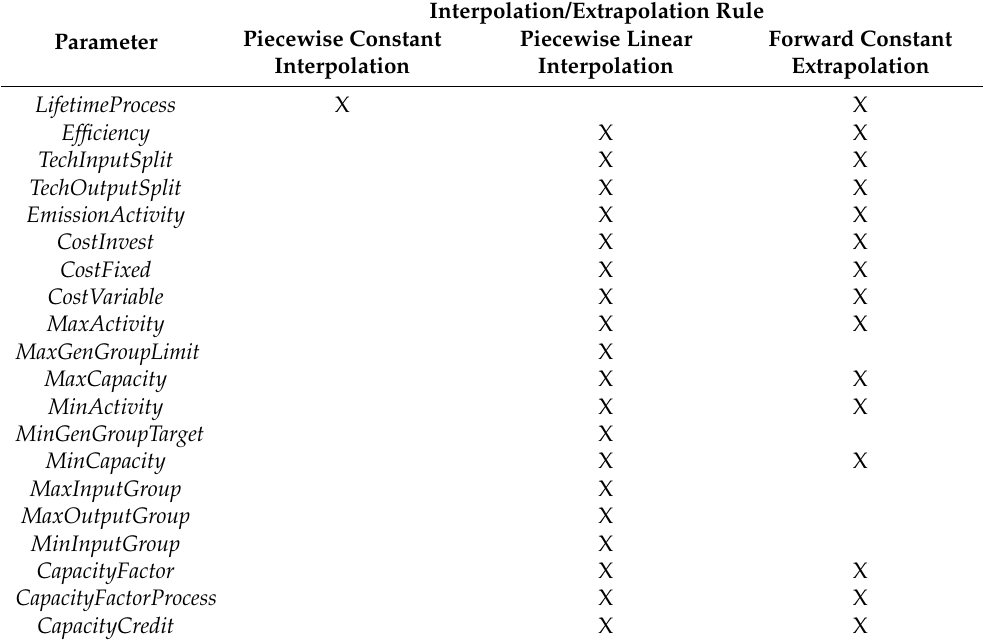
Table A1. Interpolation/extrapolation rules implemented in the preprocessing Python script. Interpolation/Extrapolation Rule Piecewise Constant Piecewise Linear Forward Constant Parameter Interpolation Interpolation